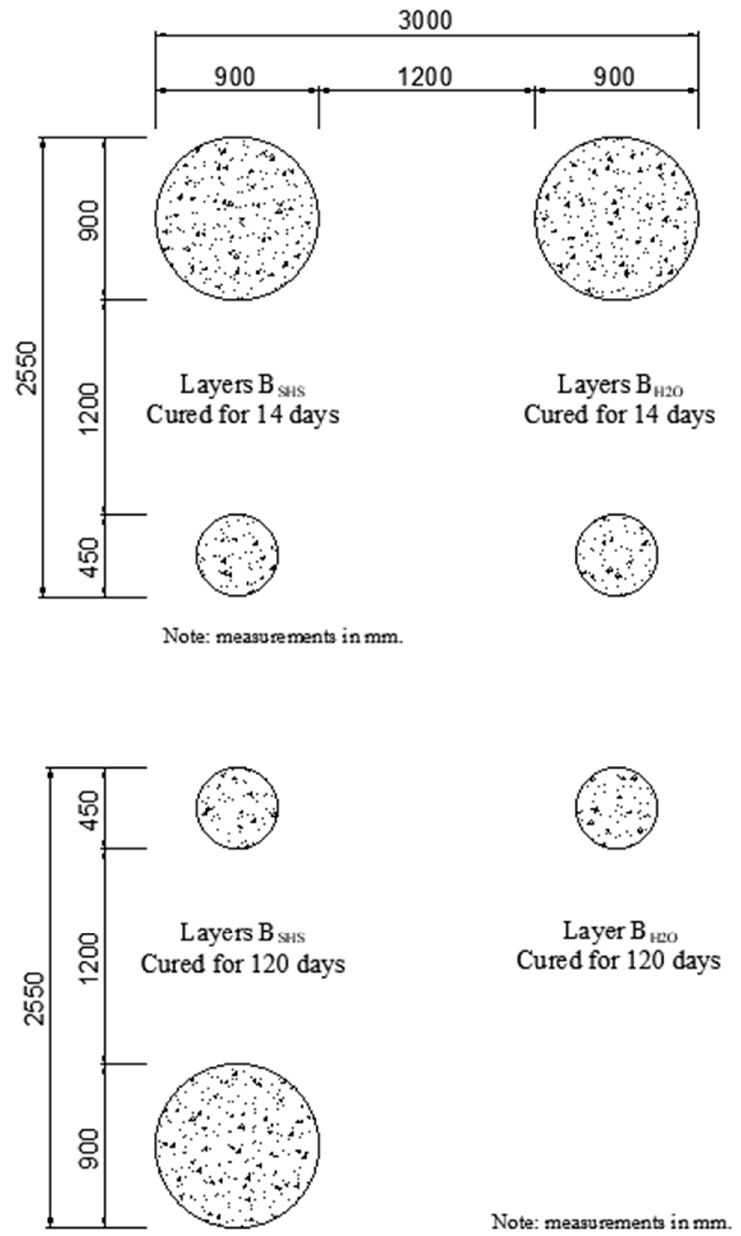
Figure 6. Relative distribution of the stabilized layers in the field.